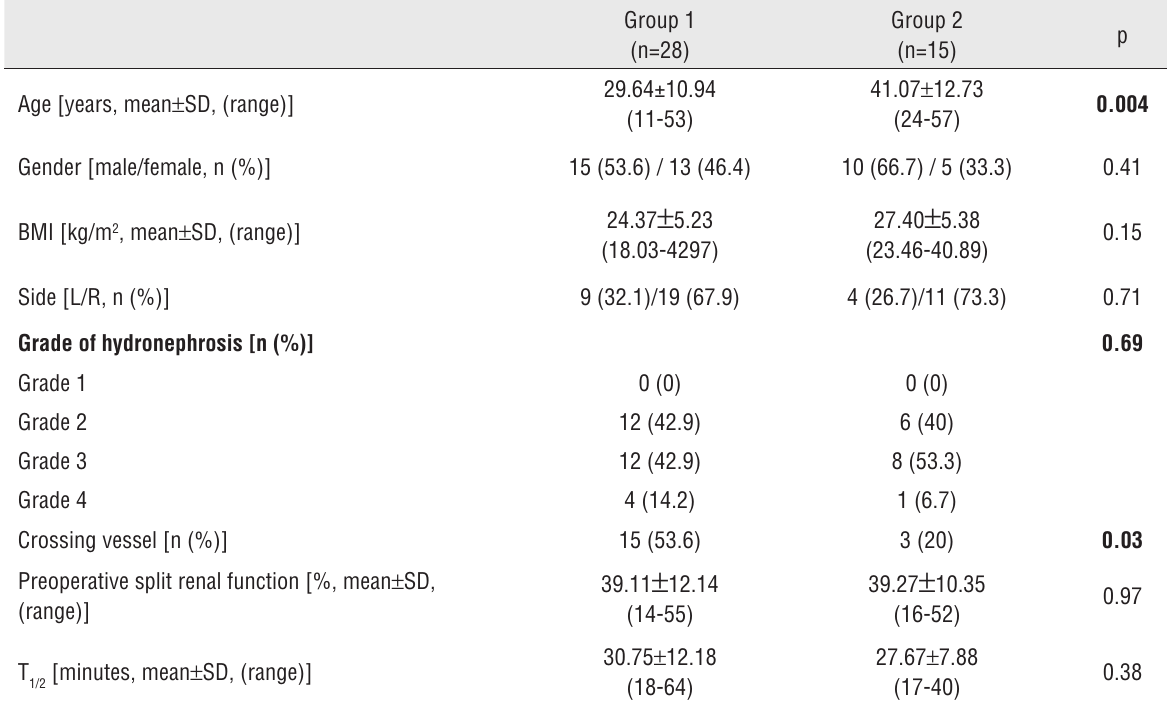
Table 1 - Baseline demographics and clinical